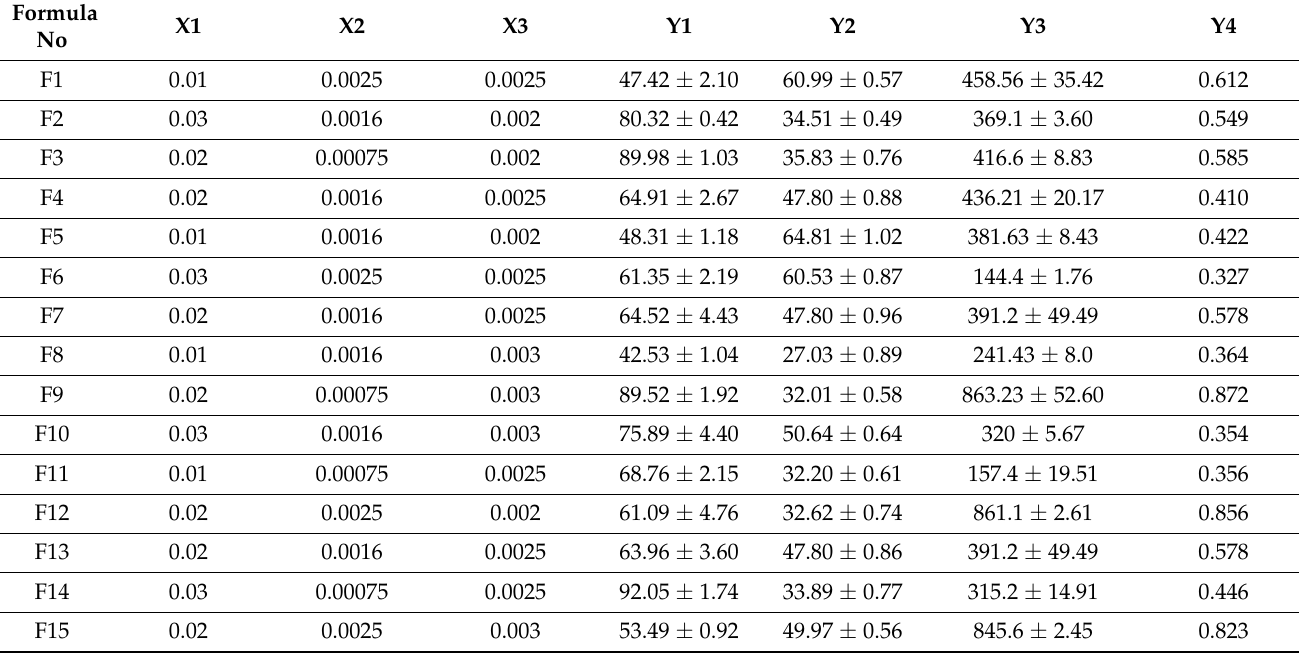
Table 2. Composition and in vitro characterization of MTX loaded gold